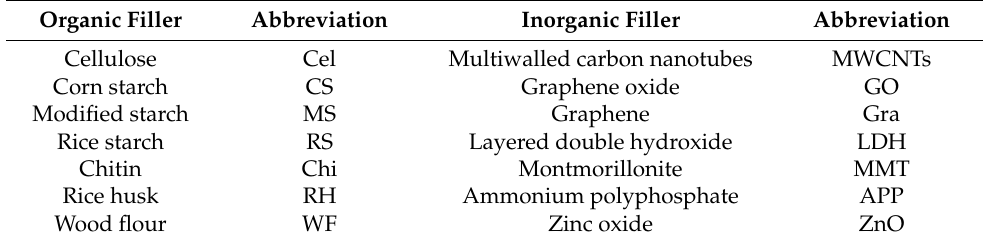
Table 1. Examples of organic and inorganic fillers utilized for preparation of biodegradable polymer